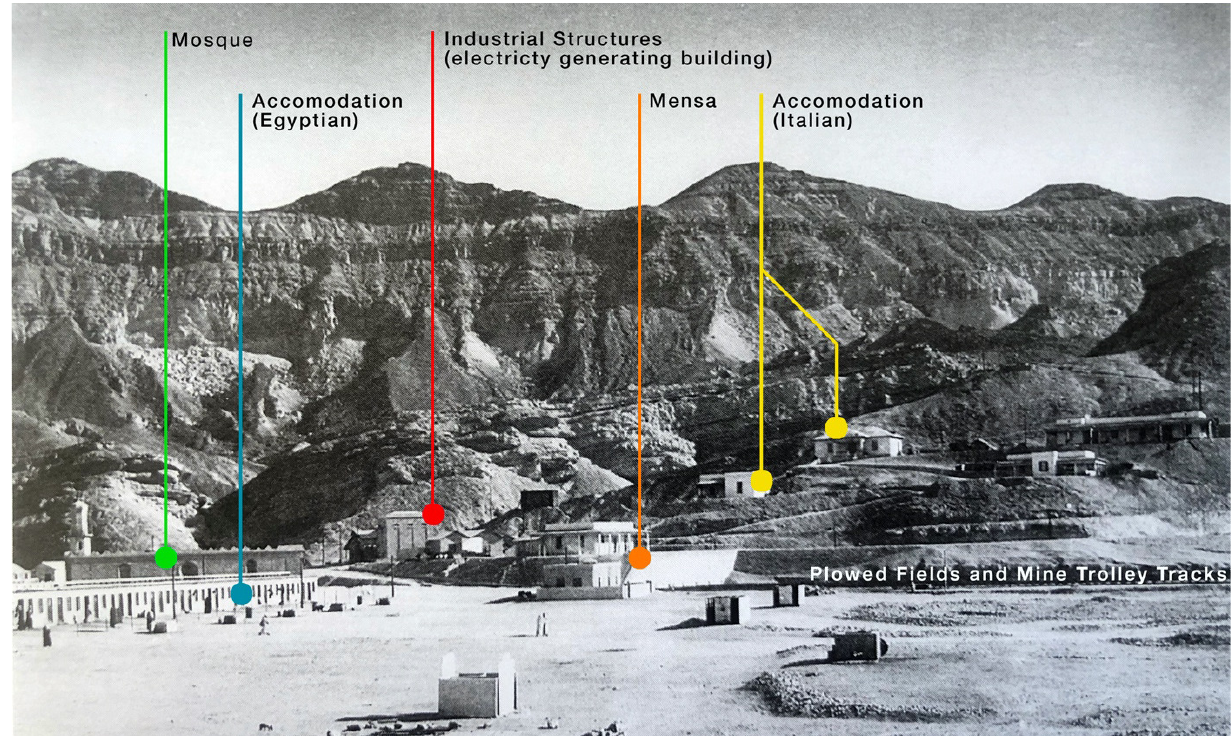
Figure 3. View of Gebel Duwi desert industrial plant. Source: Pellegrini (2011, p. 49).